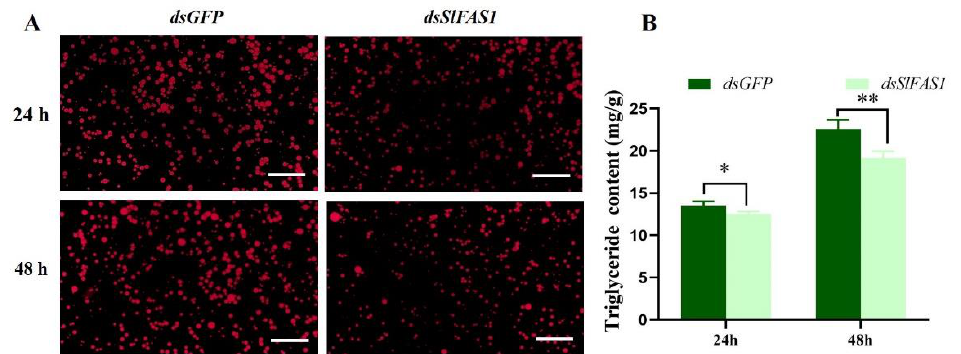
Figure 6. Lipid accumulation in the fat bodies of S. litura larvae after dsSlFAS1 . ( A ) The fat body of S. litura was stained with Nile red 24 and 48 h after dsSlFAS1 injection and examined by laser scanning microscope. Scale bar, 20 µ m. ( B ) Triglyceride content in the fat body of S. litura after dsSlFAS1 injection. Differences in the Triglyceride content was compared using a one-way analysis of variance (ANOVA) followed by Tukey’s post-hoc test. Significant differences were indicated by asterisks (* p < 0.05; ** p < 0.01).